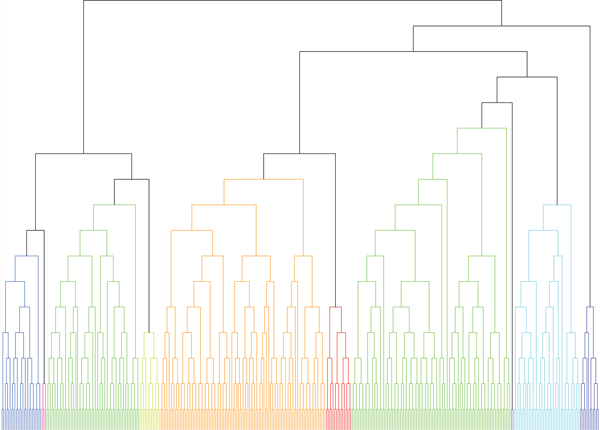
Merging bipartite networks. Merge the 372 BiNets into ten macro bipartite networks. The colors are for distinguishing different macro bipartite networks.